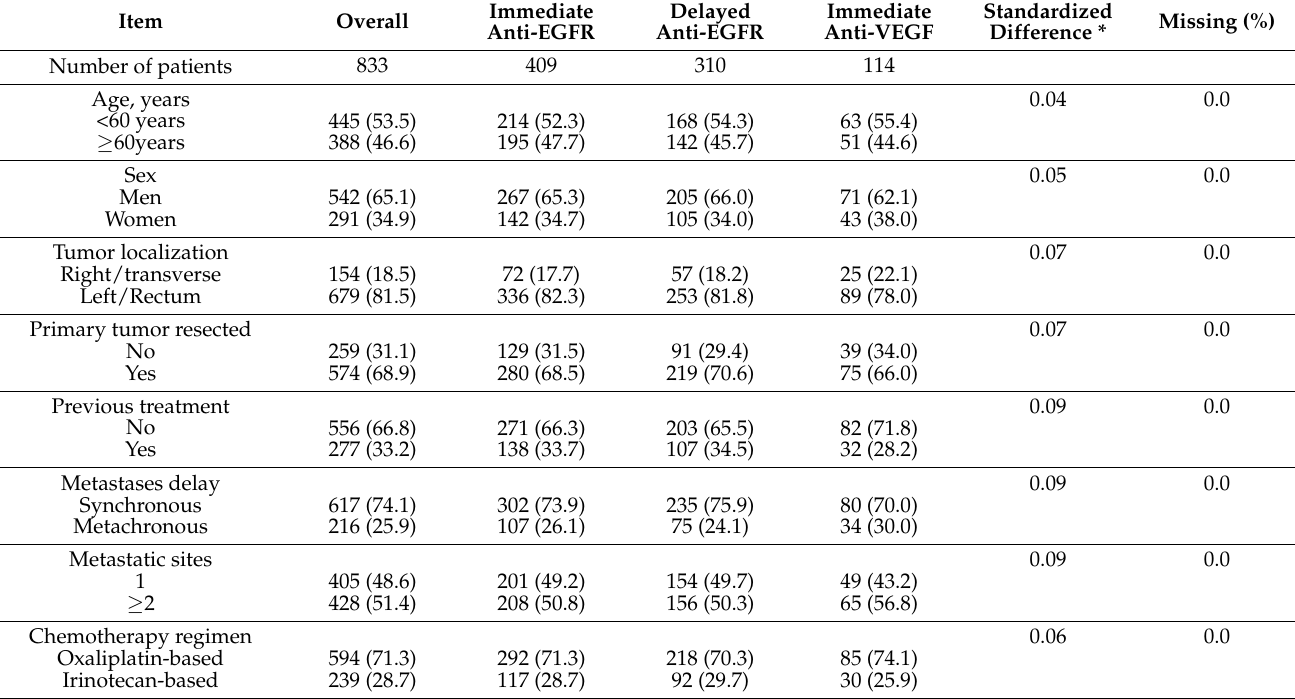
Table 2. Baseline characteristics in the weighted study